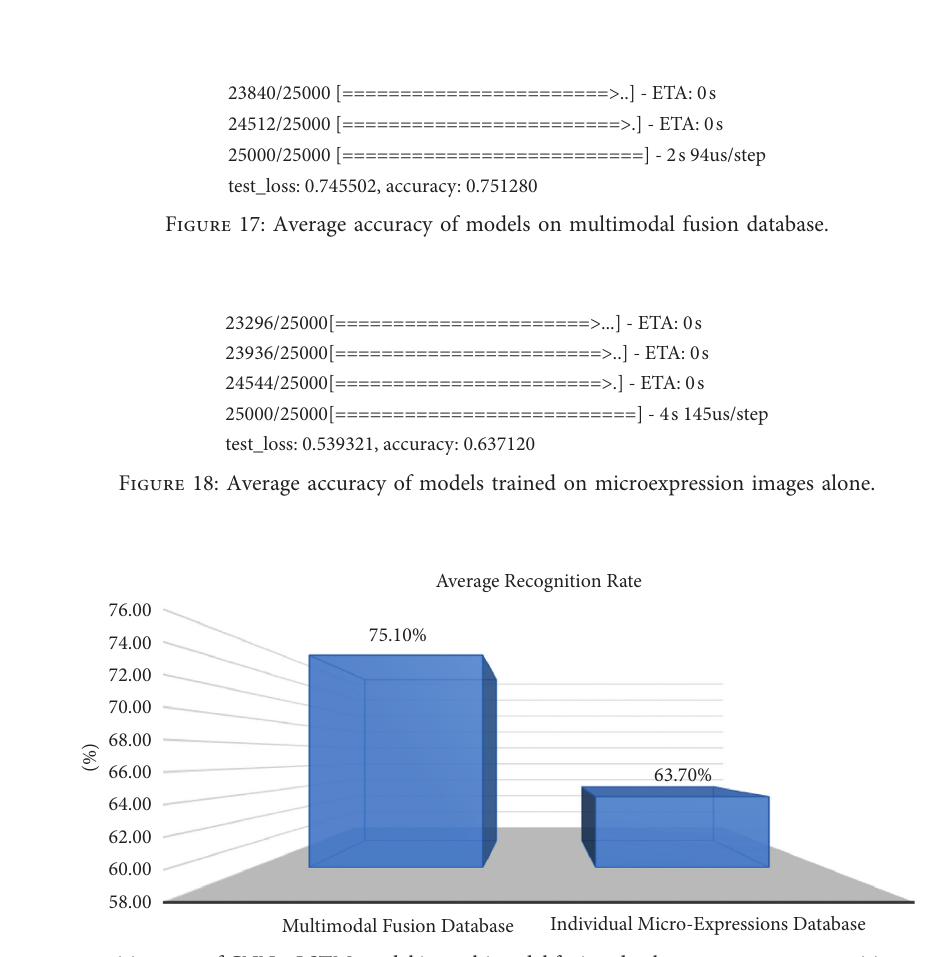
Figure 19: Average recognition rate of CNN+LSTM model in multimodal fusion database vs. average recognition rate of microexpression images trained